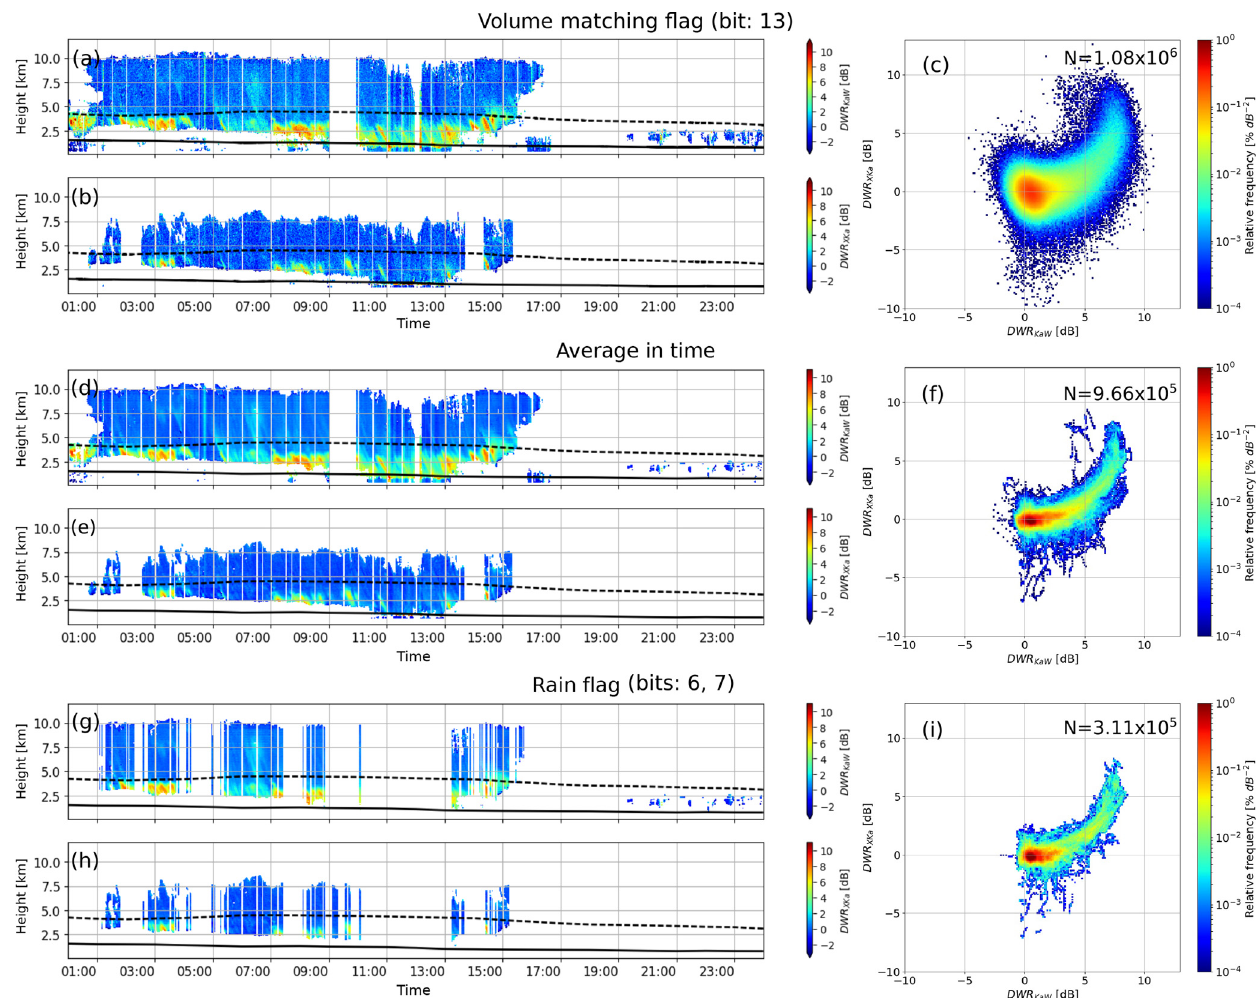
Figure 5. Same as Fig. 4, but here the effects of cumulative data filtering subject to different quality flags and averaging are illustrated. Panels (a–c) display the effect of filtering based on the DWR variance in time, which removes areas potentially affected by poor radar volume matching. The effect of the additional temporal averaging over 3min is shown in (d–f) . The effects of the removal of time periods with rain as identified by CloudNet or large liquid water paths measured by the nearby microwave radiometer are displayed in (g–i) . Note the log scale on the color bars in (c, f, i)